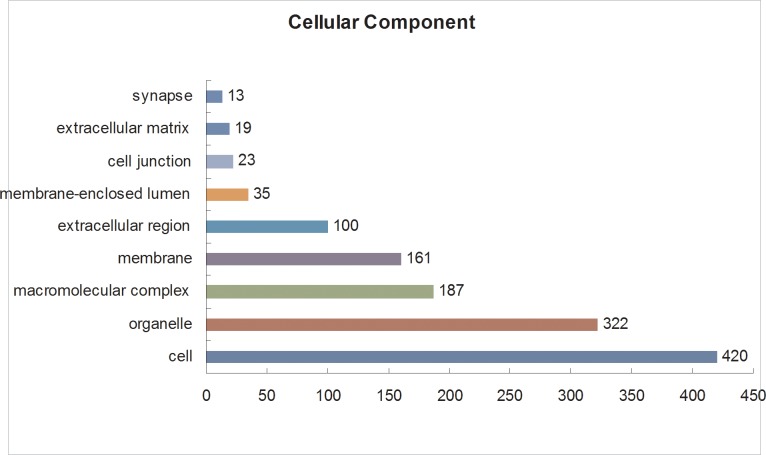
Gene Ontology (GO) cellular component analysis of the differentially expressed proteins in the pituitary gland.All data are presented on the basis of GO second-level terms. Numbers refer to assigned proteins in each category.